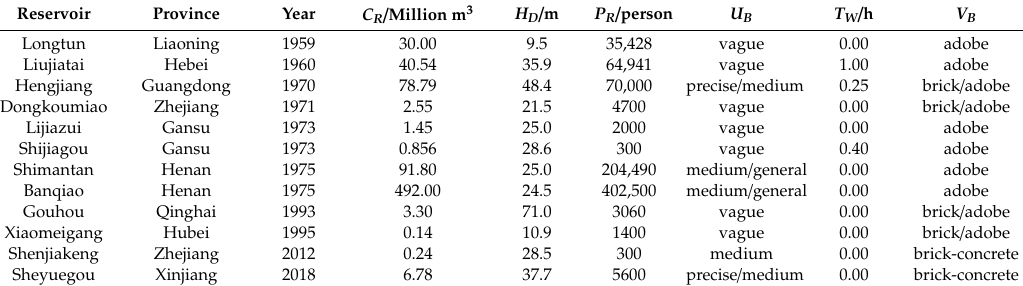
Table 4. Relevant parameters of the 12